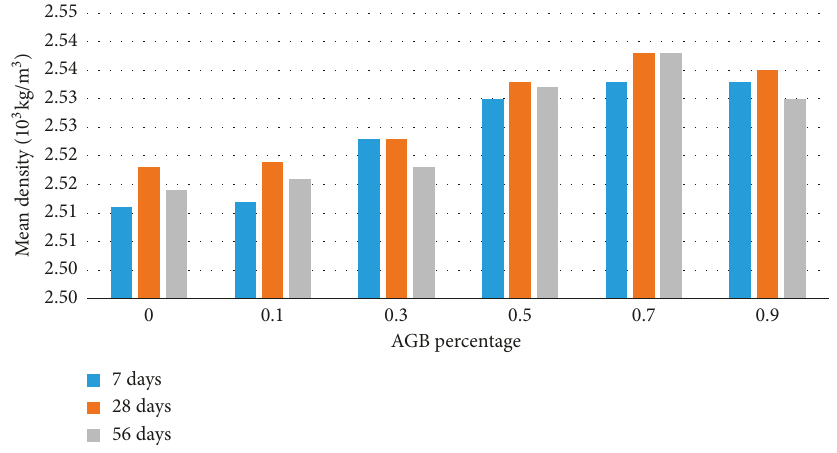
Figure 5: Variation of concrete density with AGB%. Table 3: XRF chemical components of cement and AGB cement. Chemical element